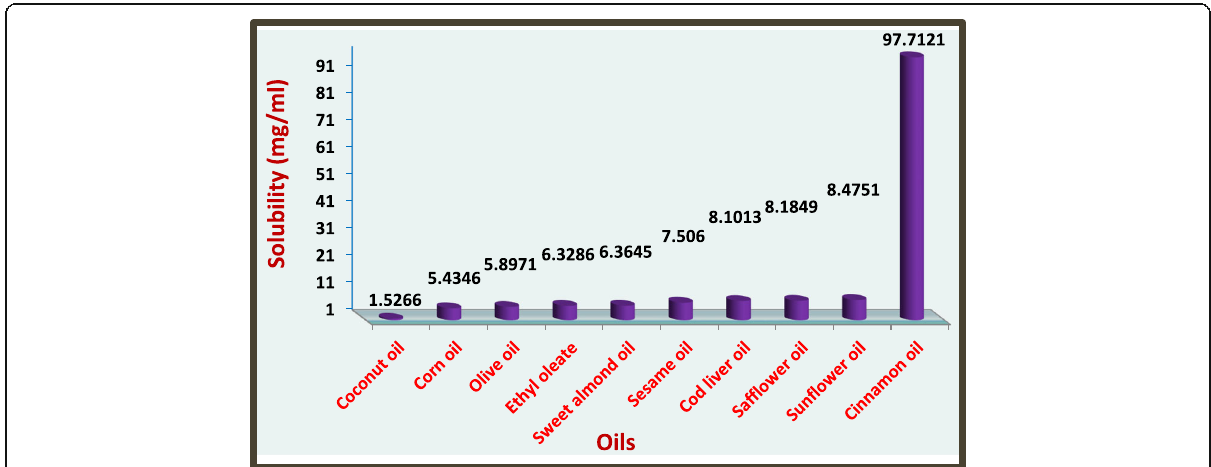
Fig. 1 Solubility study results of candesartan cilexetil in different